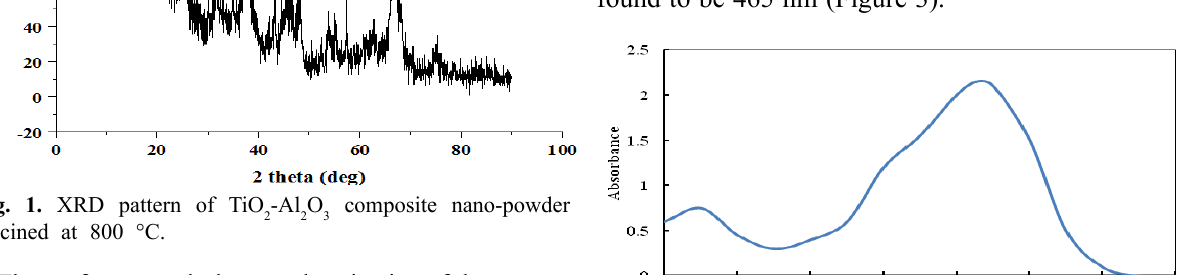
-Al O composite nano-powder 2 2 3